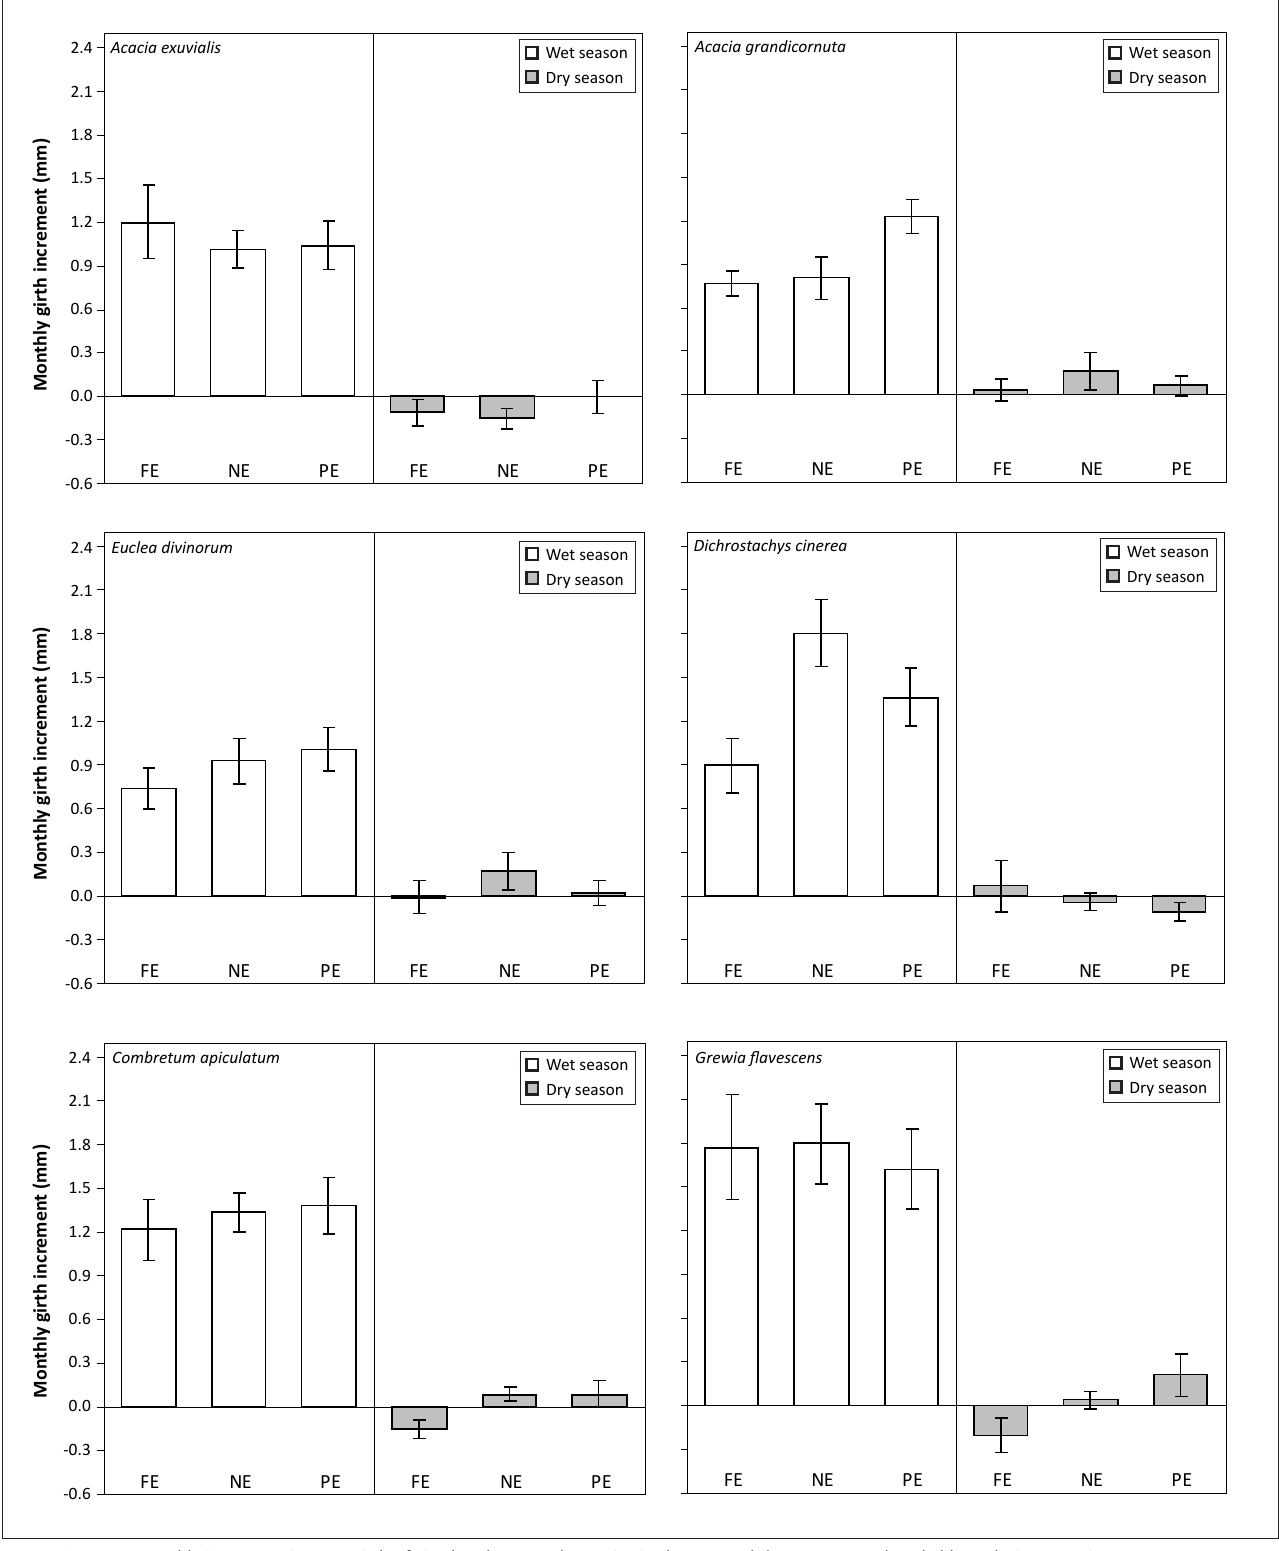
FIGURE 3: Mean monthly increment in stem girth of six abundant woody species in the wet and dry seasons at the Nkuhlu exclusion experiment, 2006–2010. Error bars are standard errors of the means (for columns FE, NE and PE, n = 13, 15 and 14 for Acacia exuvialis ; 12, 15 and 12 for Acacia grandicornuta , Euclea divinorum , Dichrostachys cinerea and Combretum apiculatum ; and 12, 18 and 12 for Grewia flavescens ). FE, exclusion of all large herbivores greater than hares; NE, control (no exclusion); PE, exclusion of elephants and giraffe